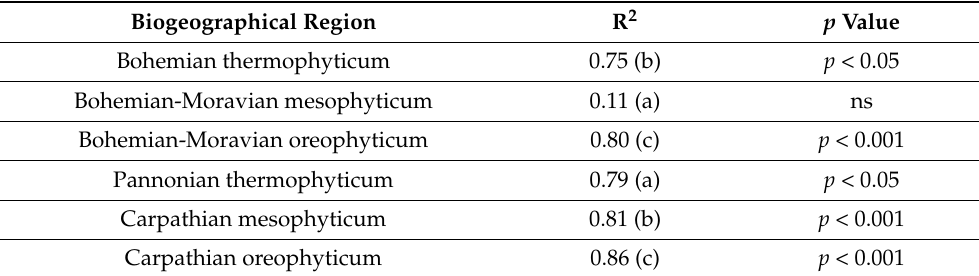
Table 1. Summary statistics of the polynomial regressions used for determining the relationship between the total number of orchid taxa and altitude present in each phytogeographical